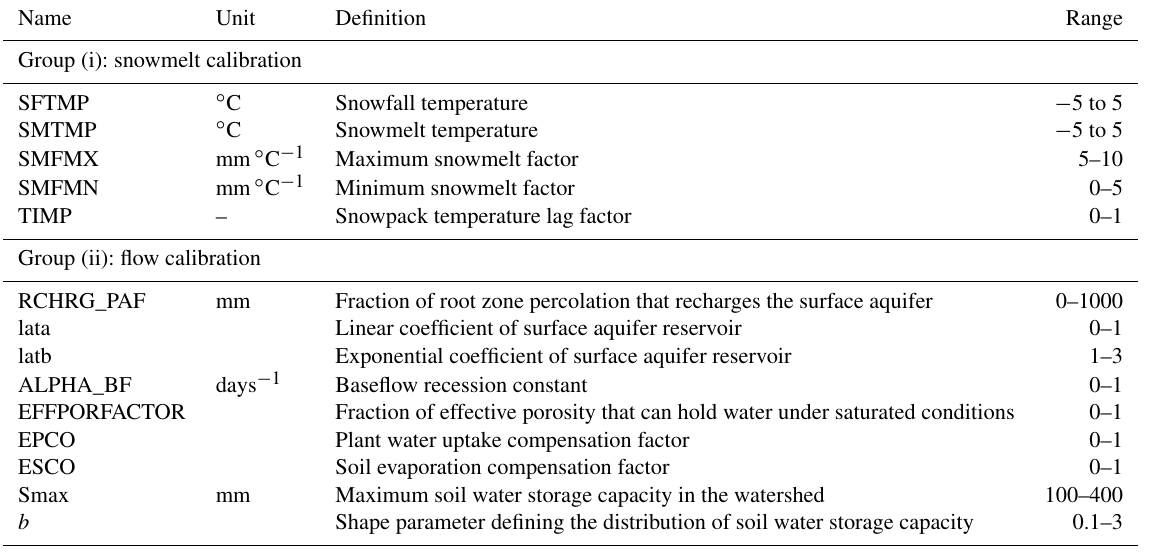
Table 1. SWAT-HS parameters for streamflow calibration.